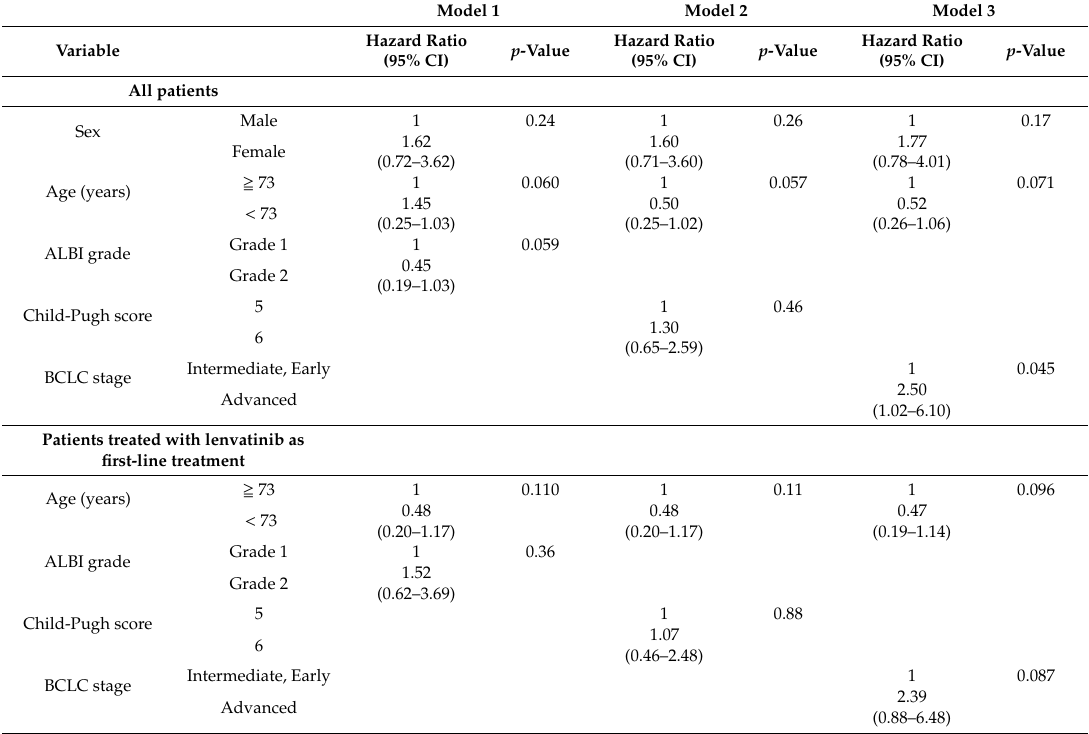
Table 3. Results of multivariate analyses relevant to overall survival in all patients ( n = 110) and in patients treated with lenvatinib as first-line treatment ( n =